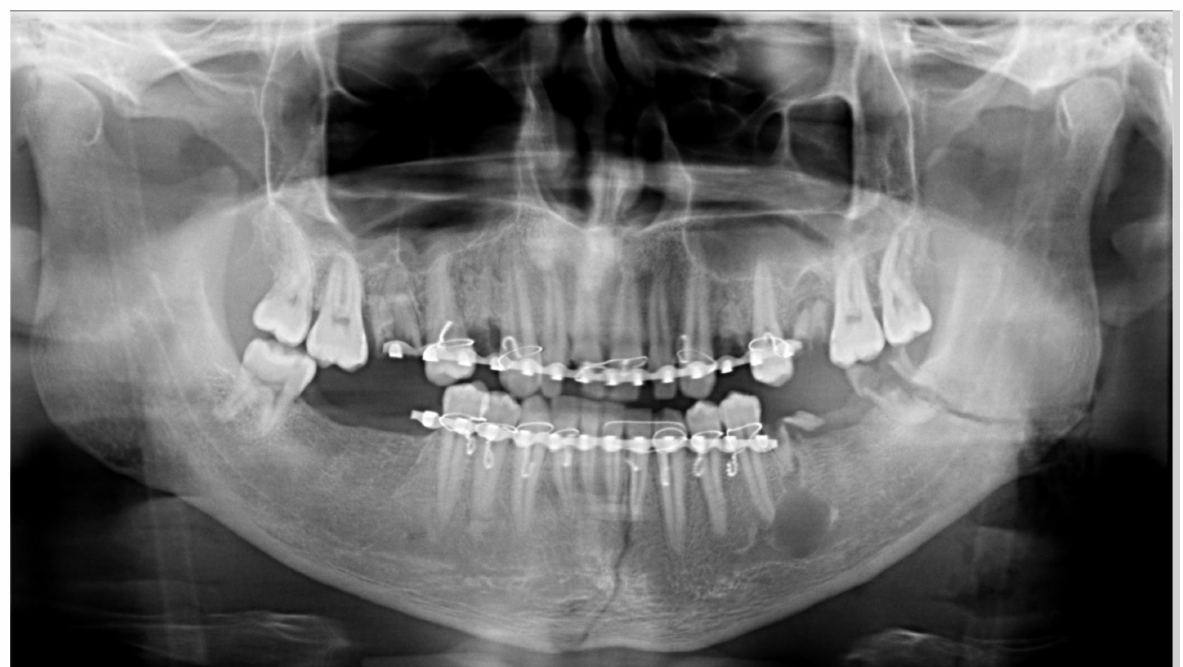
Figure 4. Orthopantomography in a patient with a double mandible fracture presents a positioning error, with lateral rotation of the head towards the left side and, consequently, an obvious asymmetry in the image. The errors are caused by the impossibility of using the bite-block when applying bimaxillary immobilization.